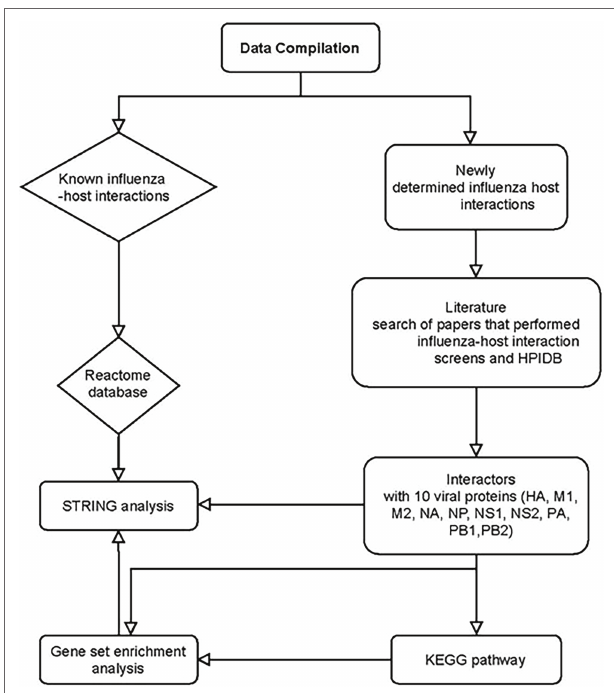
FIGURE 1 | Bioinformatics analysis of influenza and host interactors. HPIDB: Human Pathogen Interactions Database. Host interactors of influenza were separated into known and newly determined interactions. PubMed search of Viral–host interactome studies (IP-MS, Y2H, computer homology) was conducted. Papers were filtered if they were in English and full data set was available for analysis. Compiled data set of interactors was analyzed using STRING, Gene set enrichment analysis, and KEGG